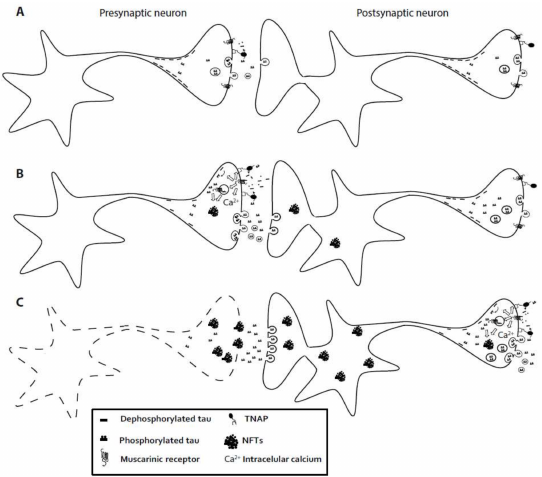
Figure 1. Schematic representation illustrating the involvement of TNAP in the progression of Alzheimer’s disease. ( A ) Under physiological conditions, a moderate amount of tau protein can reach the interstitial space by different mechanisms. ( B ) As a consequence of an initial undetermined event, an unusual neuronal activity is induced, increasing tau secretion into the extracellular space. At this location, tau is dephosphorylated by TNAP becoming an active ligand of muscarinic receptors. The activation of muscarinic receptors by tau has four main consequences: First, a sustained increase in intracellular calcium levels that could compromise intracellular calcium homeostasis; Second, an increase of intracellular tau phosphorylation favoring the formation of NFTs; Third, higher expression levels of TNAP; Finally, possible receptor internalization following tau-induced muscarinic receptor activation. As result of these events, tau secretion would be increased, generating a positive feedback loop at the presynaptic level that finally leads to synaptic dysfunction. In the meantime, at the postsynaptic level, internalization of extracellular tau protein would take place. ( C ) As a result of this vicious cycle, neuronal functionality could be compromised, causing the rupture of the plasma membrane of the presynaptic neuron, with release of its intracellular content, including the NFTs, into the interstitial space. Since NFTs will undergo a slow disassembly and degradation, they will behave as new sources of extracellular tau, promoting the postsynaptic uptake of extracellular tau and the generation of NFTs at postsynaptic level. Finally, this event will stimulate the phosphorylation of intracellular tau resulting in a higher tau secretion also in the postsynaptic neuron, thus favoring the vicious cycle described above and the spreading of the